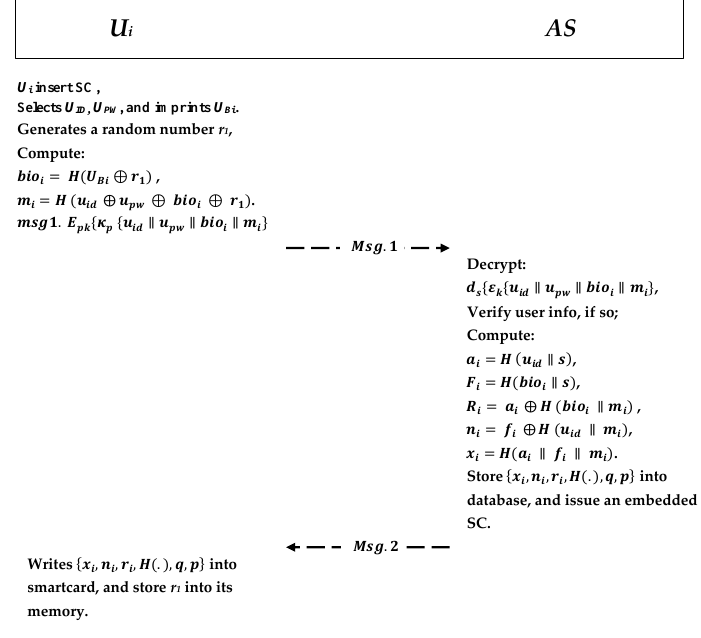
Figure 5. User registration